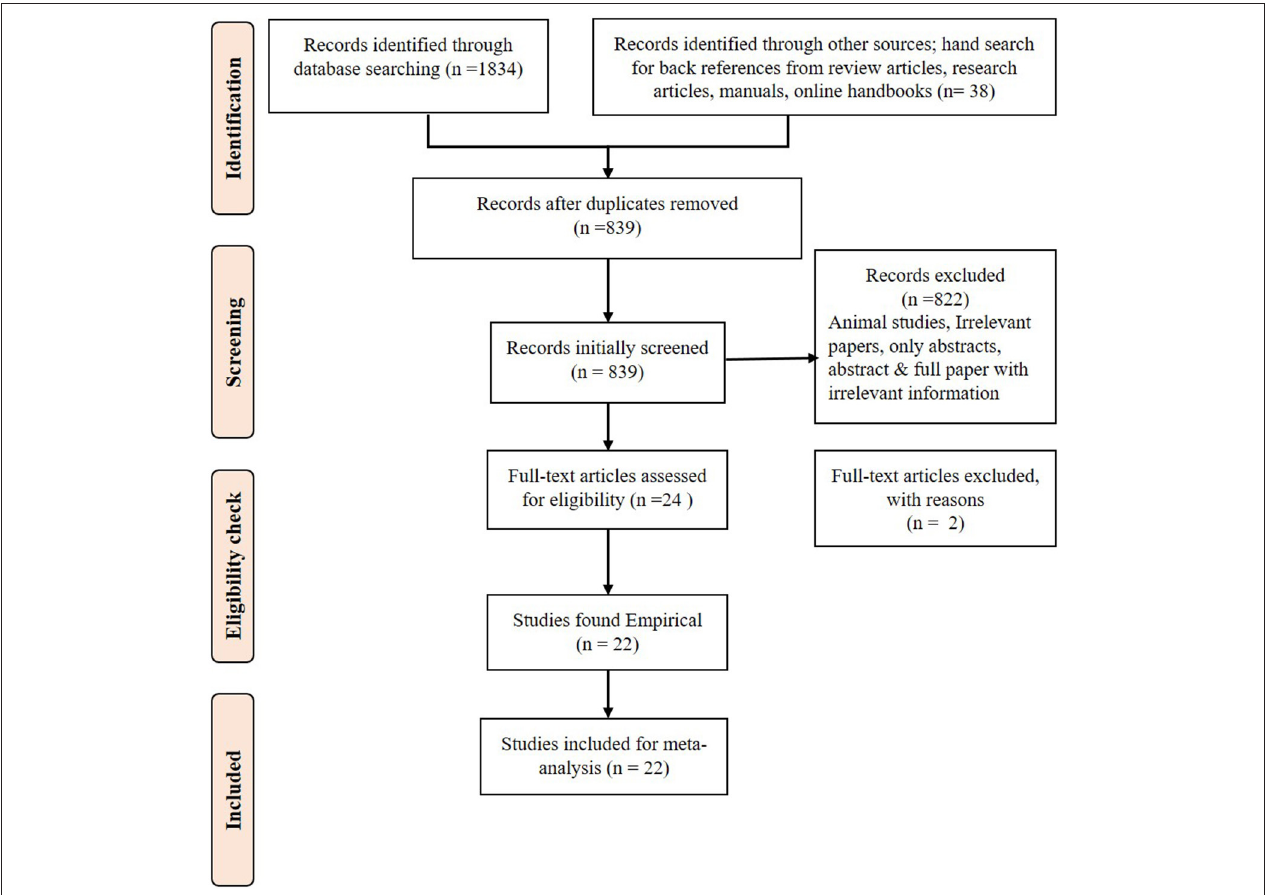
FIGURE 1 | PRISMA flow diagram for systematic